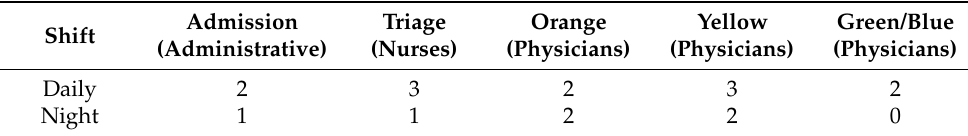
Table 1. Medical staff per